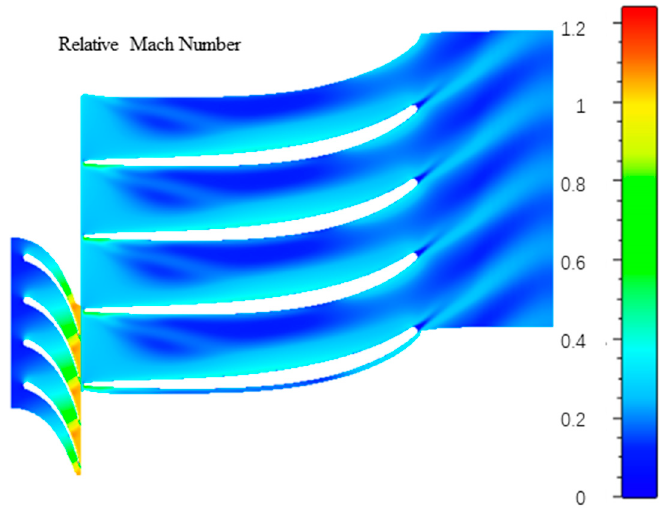
Figure 6. The contour of relative Mach number at 50% blade span.